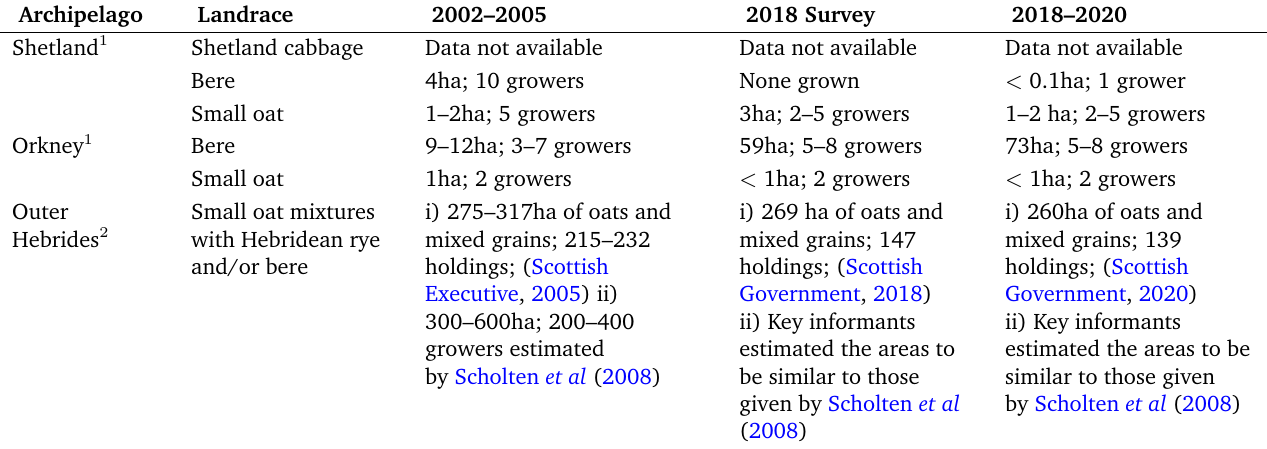
Table 2. Approximate area of landraces grown and estimated grower numbers in the Scottish archipelagos.